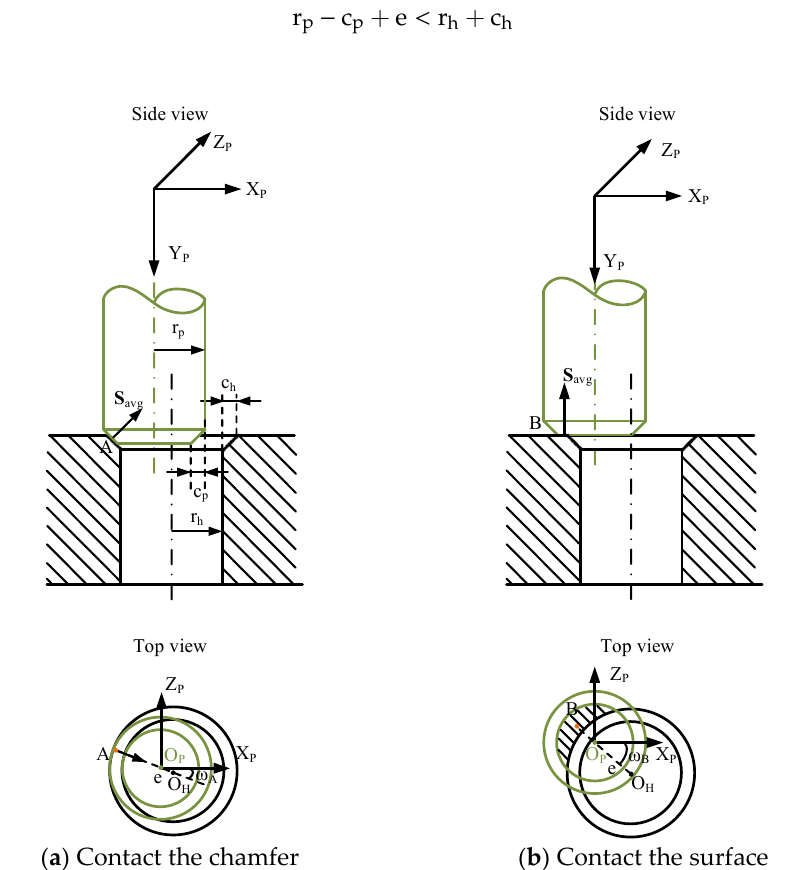
Figure 8. The contact conditions between the peg and hole during the F/T locating process.